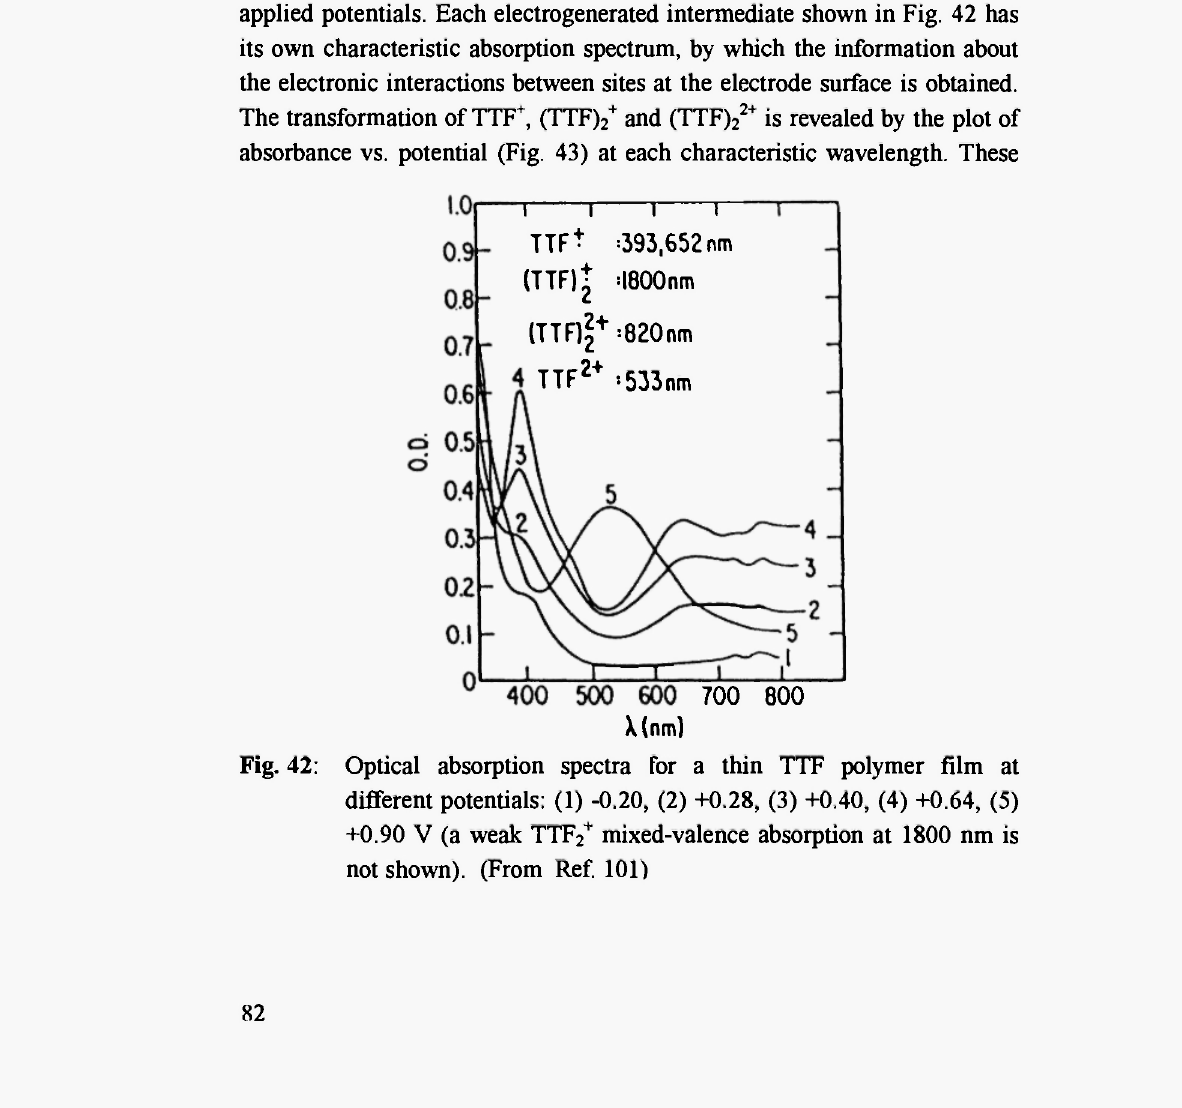
Fig. 42: Optical absorption spectra for a thin TTF polymer film at different potentials: (1) -0.20, (2) +0.28, (3) +0.40, (4) +0.64, (5) +0.90 V (a weak TTF 2 + mixed-valence absorption at 1800 nm is not shown). (From Ref.